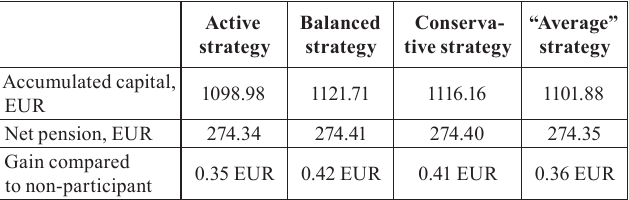
Theoretical Pension of Pillar II Participant in Latvia